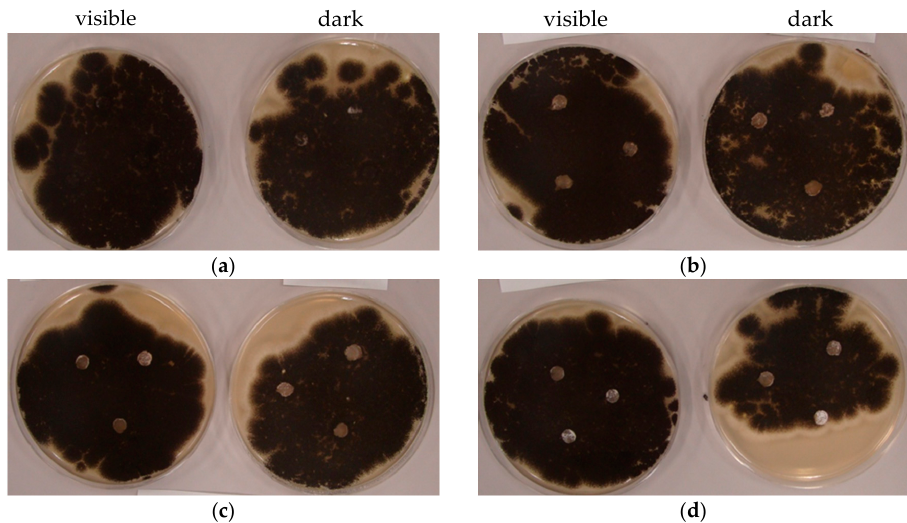
Figure 7. The photographs of Aspergillus niger colony on Malt Extract Agar (MEA) plates: ( a ) 0.9% NaCl (control), ( b ) CuST-01m-1h, ( c ) CuFP6m-1h, ( d ) CuST-41m-1h, incubated under vis (left) and in the dark (right).